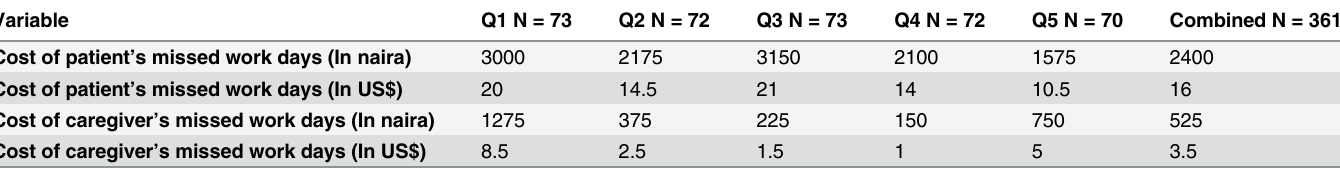
Table 6. Average monthly cost of productivity loss by